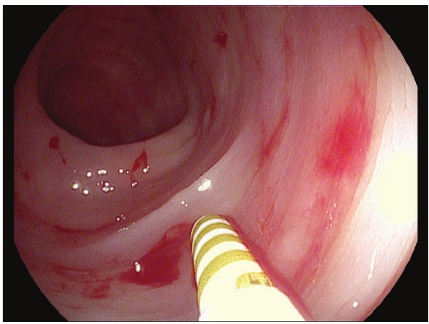
Figure 2: Application of bipolar cautery using 7-French probe to colonic Dieulafoy’s lesion.